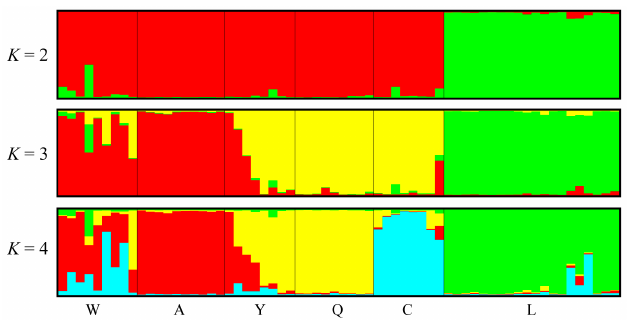
Figure 4. Bayesian clustering analysis of population structure of P. bungeana .